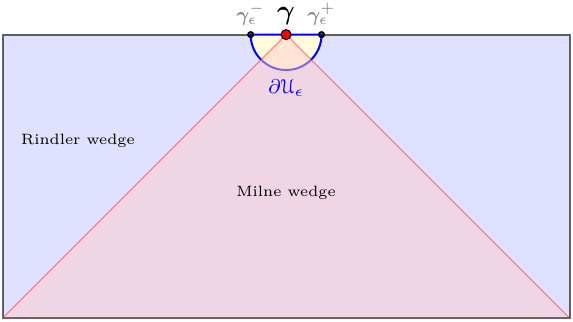
Figure 4 . The geometry in the vicinity of the splitting surface γ in the Lorentzian geometry dual to a single fundamental domain c M . We have excised a neighbourhood U of γ with boundary n (cid:15) ∂ U (cid:15) to regulate the contribution from the fixed point locus. We take ∂ U (cid:15) to be parametrized by an arbitrary curve ˜ x + = U (˜ x − ) in the ˜ x ±